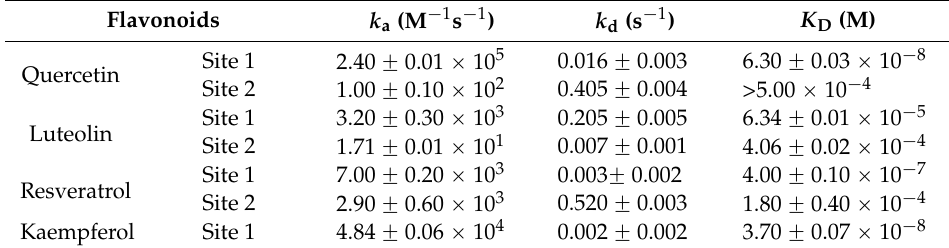
Table 1. Kinetic constants determined at 25 °C (HSA with flavonoids).